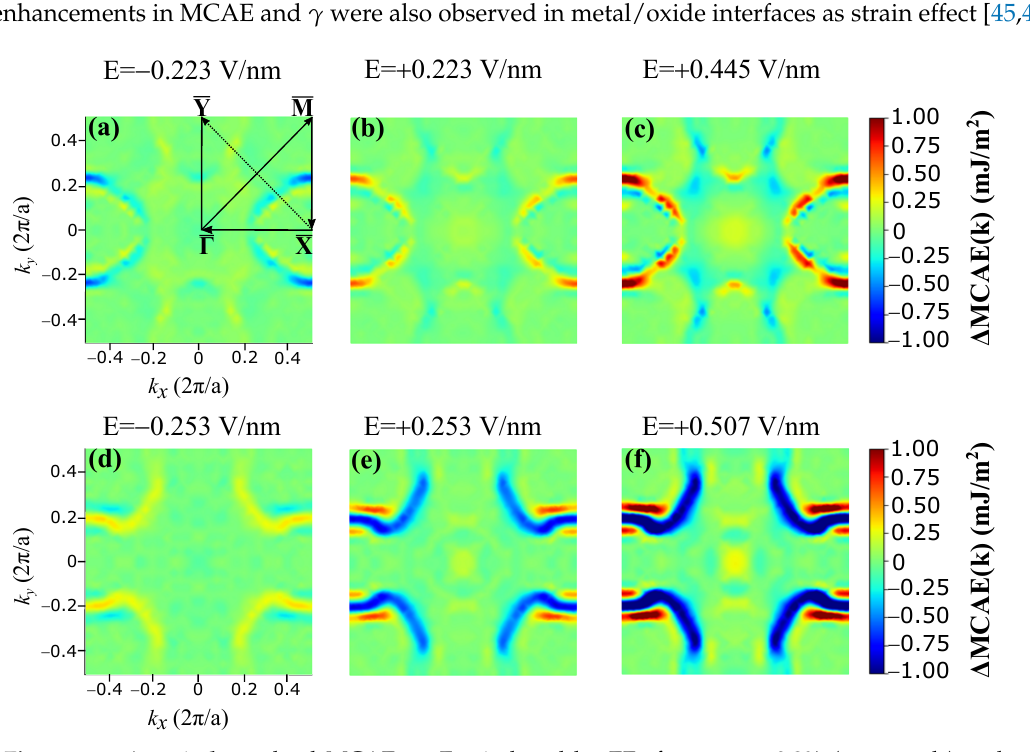
Figure 11. Atomic k -resolved MCAE on Fe 1 induced by EFs for η Fe = + 0.3% (top panels) and η Fe = 5.9% (down panels). ( a ) E = 0.223 V/nm, ( b ) E = + 0.223 V/nm, ( c ) E = + 0.445 V/nm, − − ( d ) E = 0.253 V/nm, ( e ) E = + 0.253 V/nm, and ( f ) E = + 0.507 −